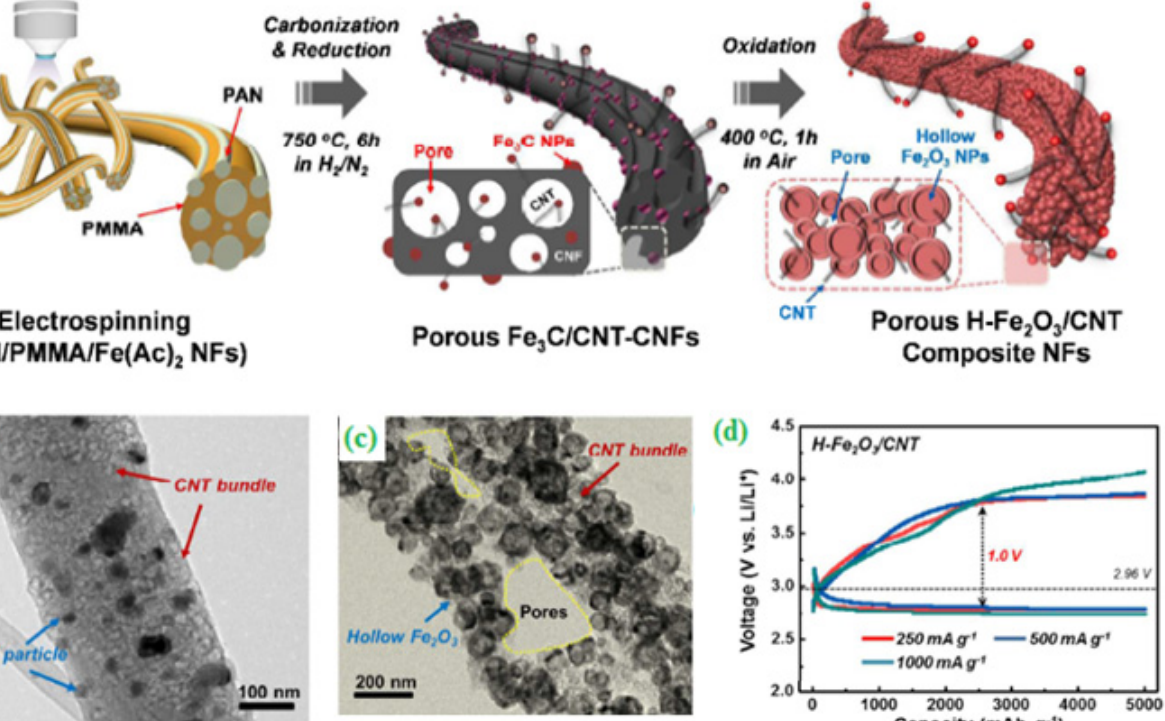
Figure 4. ( a ) Schematic illustration for the synthetic protocol of porous H-Fe 2 O 3 /CNT NFs, ( b ) TEM images of Fe 3 C/CNT-CNFs, ( c ) TEM images of H–Fe 2 O 3 /CNT NFs , ( d ) Comparison of overpoten- tials of H–Fe 2 O 3 /CNT NFs with a capacity limit of 5000 mAh g –1 running at different rates (250,